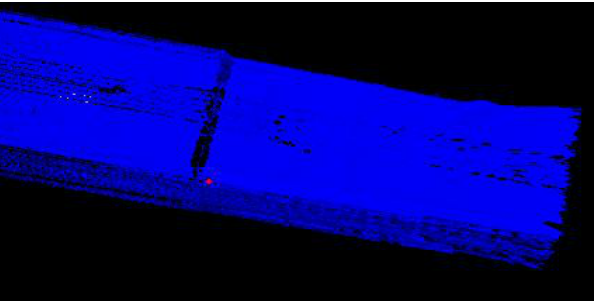
Figure 8. A model of the tunnel after one